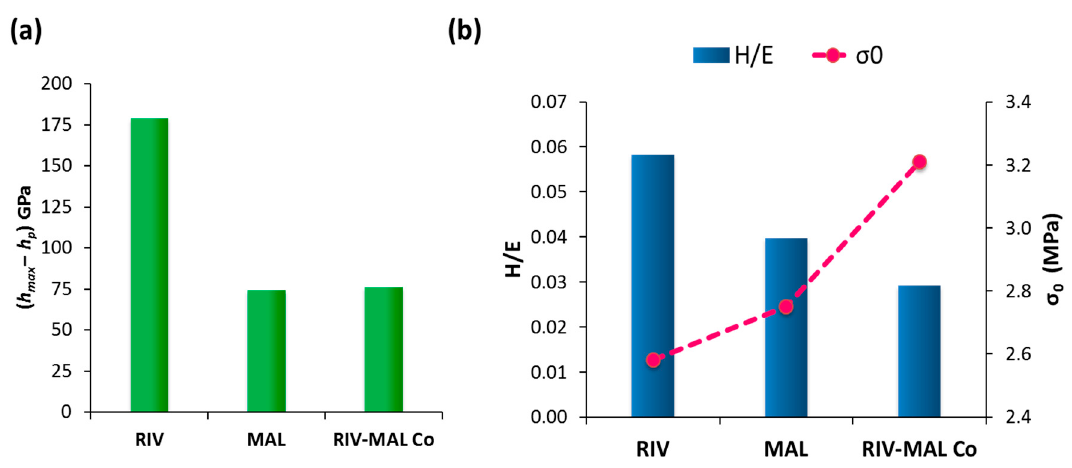
Figure 6. Nanoindentation parameters for crystal deformation representing ( a ) The ( h max ‒ h p ) values depicting elastic recovery for crystals of RIV, MAL, and RIV-MAL Co; ( b ) Inverse correlation of H / E ratio (primary axis) and interparticulate bonding strength, σ 0 (secondary axis).